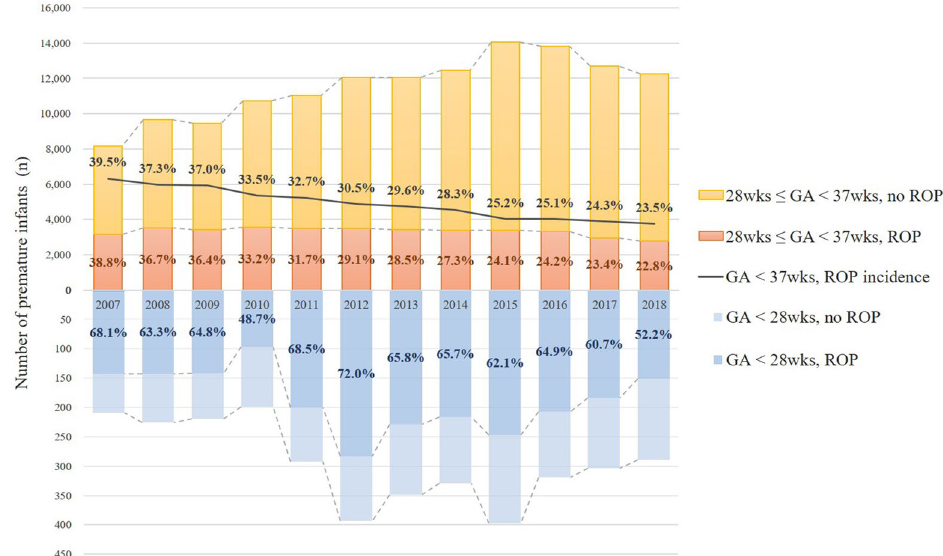
Figure 2. Twelve-year trend of incidence of retinopathy of prematurity (ROP) among premature infants according to gestational age (GA) groups. The stacked bar graph above the horizontal axis indicates the annual number of premature infants of 28 weeks ≤ GA < 37 weeks, with and without ROP, and incidence of ROP (%). The stacked bar graph below the horizontal axis indicates the annual number of premature infants of GA < 28 weeks, with and without ROP, and incidence of ROP (%). The line graph indicates the annual incidence of ROP among premature infants with a GA < 37 weeks. GA gestational age, ROP retinopathy of prematurity.